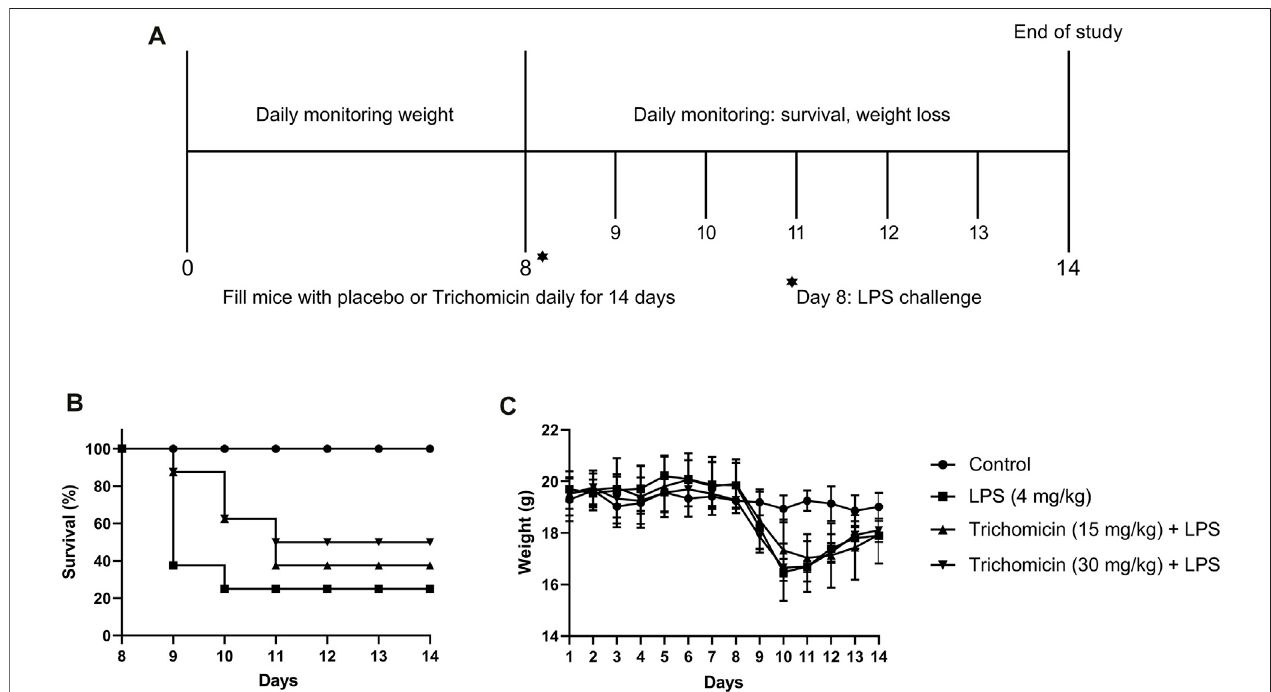
FIGURE6| TrichomicinprotectedmicefromLPSchallenge. (A) OverviewofstudiesinvestigatingtheuseofTrichomicinasatherapeuticforLPSinfection. BALB/c mice were challenged with 4 mg/kg of LPS. Mice received a 14-day ’ s intragastrically treatment of Trichomicin or placebo. (B) Survival rate within the 14 days ’ study. (C) Weight changes during the 14